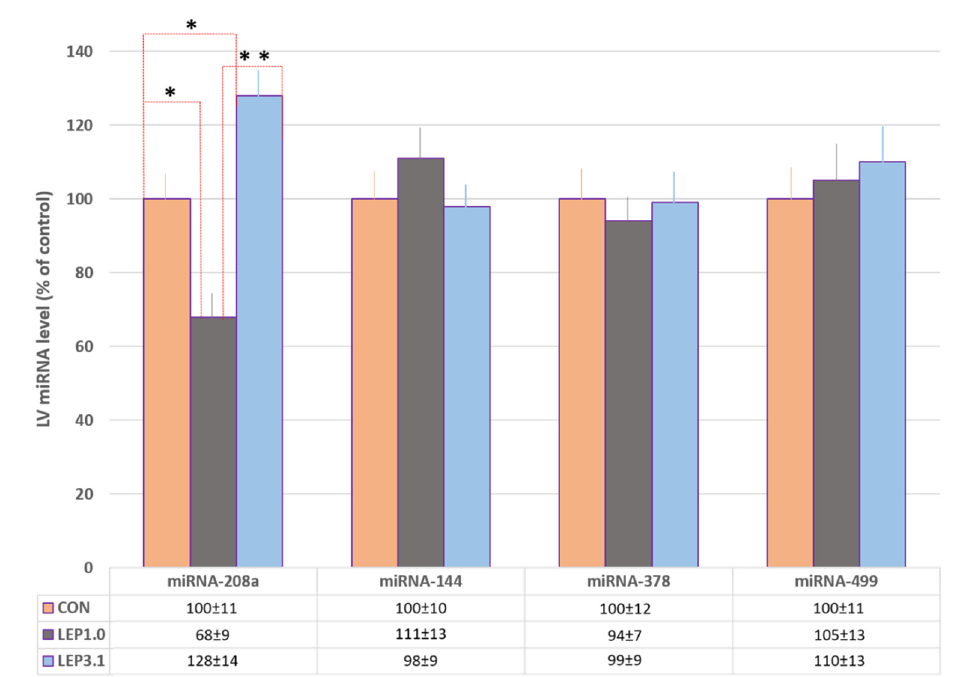
Figure 7. miRNA expression in rat LV myocardium. CON, control; LEP1.0, leptin 1.0 nM; LEP3.1, leptin 3.1 nM. Data are presented as mean ± standard error of the mean. * p < 0.001; ** p =